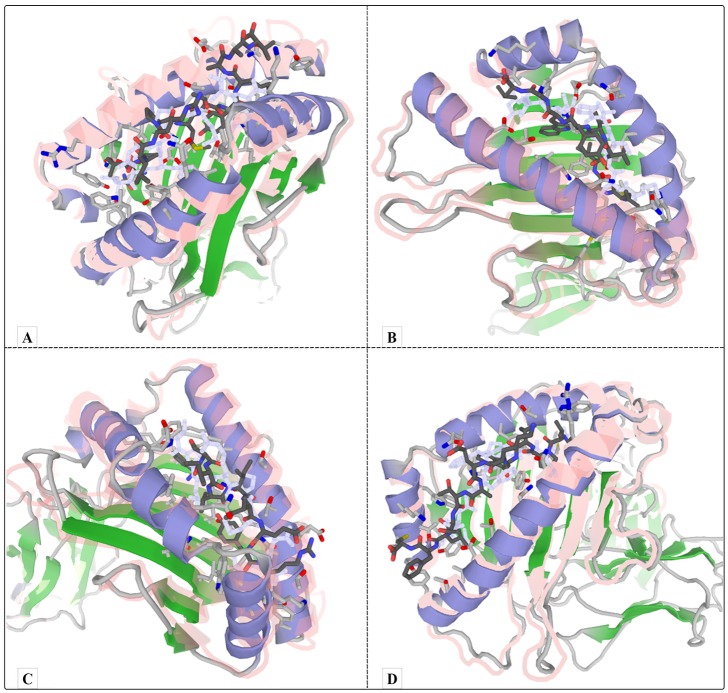
Molecular docking.A) Successful Peptide-Protein Docking between NEF72–84 and HLA B5601 with interaction scores of 316.0, B) Successful Peptide-Protein Docking between VIF63–71 and HLA A0301 with interaction scores of 216.0, C) Successful Peptide-Protein Docking between VPU22–30 and HLA B1301 with interaction scores of 193.0, D) Successful Peptide-Protein Docking between GP16041−53 and HLA A6801 with interaction scores of 240.0.